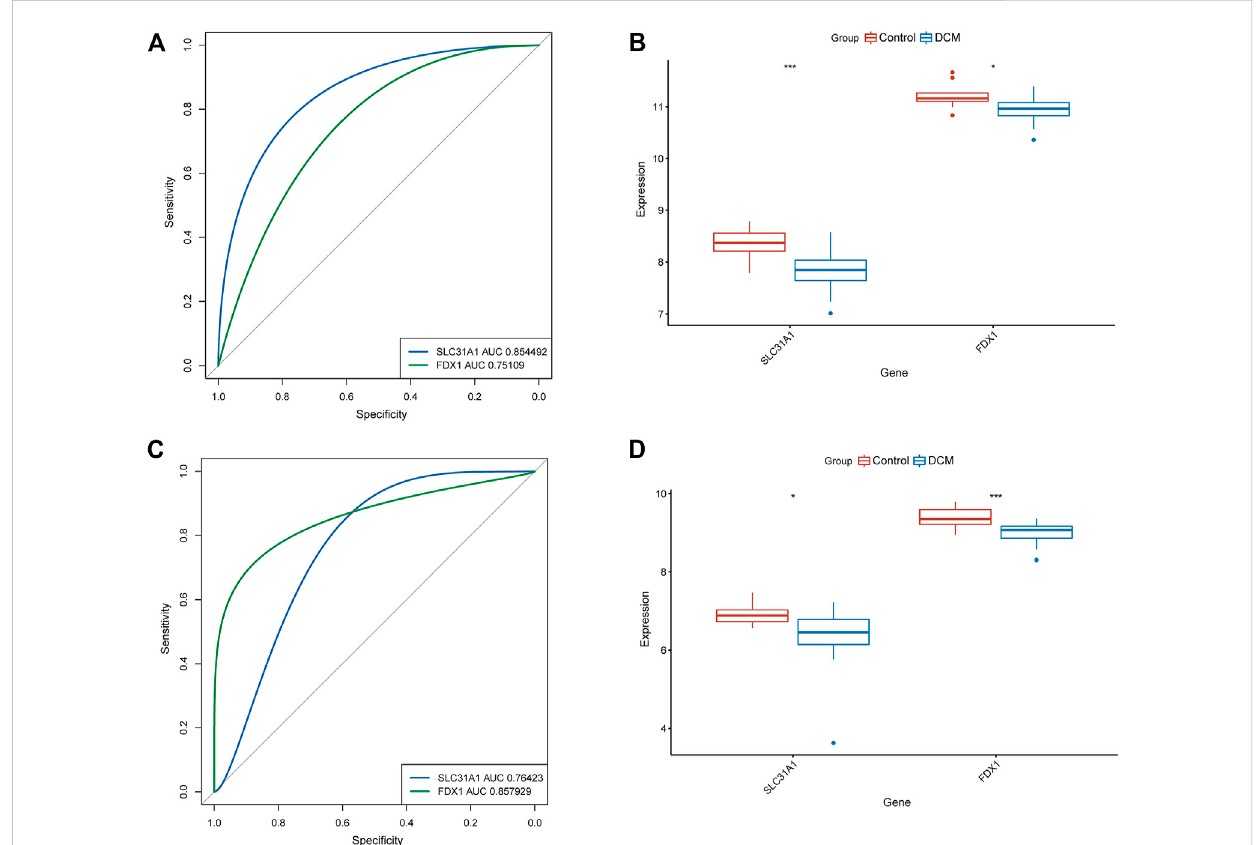
FIGURE 4 Validationofsignaturegenes. (A) ROCcurvesshowingthediagnosticperformanceofsignaturegenesinGSE19303. (B) Validationofsignaturegenes in GSE19303. * represents p < 0.05; ** represents p < 0.01; *** represents p < 0.001. (C) ROC curves showing the diagnostic performance of signature genes in GSE21610. (D) Validation of signature genes in GSE21610. * represents p < 0.05; ** represents p < 0.01; *** represents p <